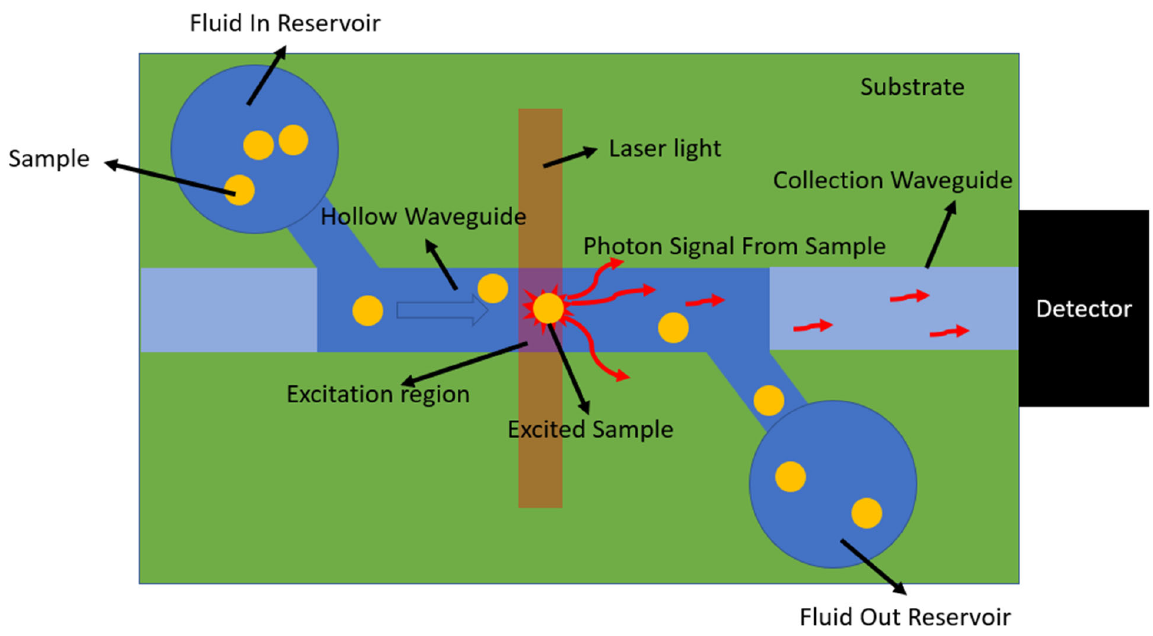
Figure 4. Diagram of a flow-through biosensor showing particles passing through the excitation region and giving o ff photons.